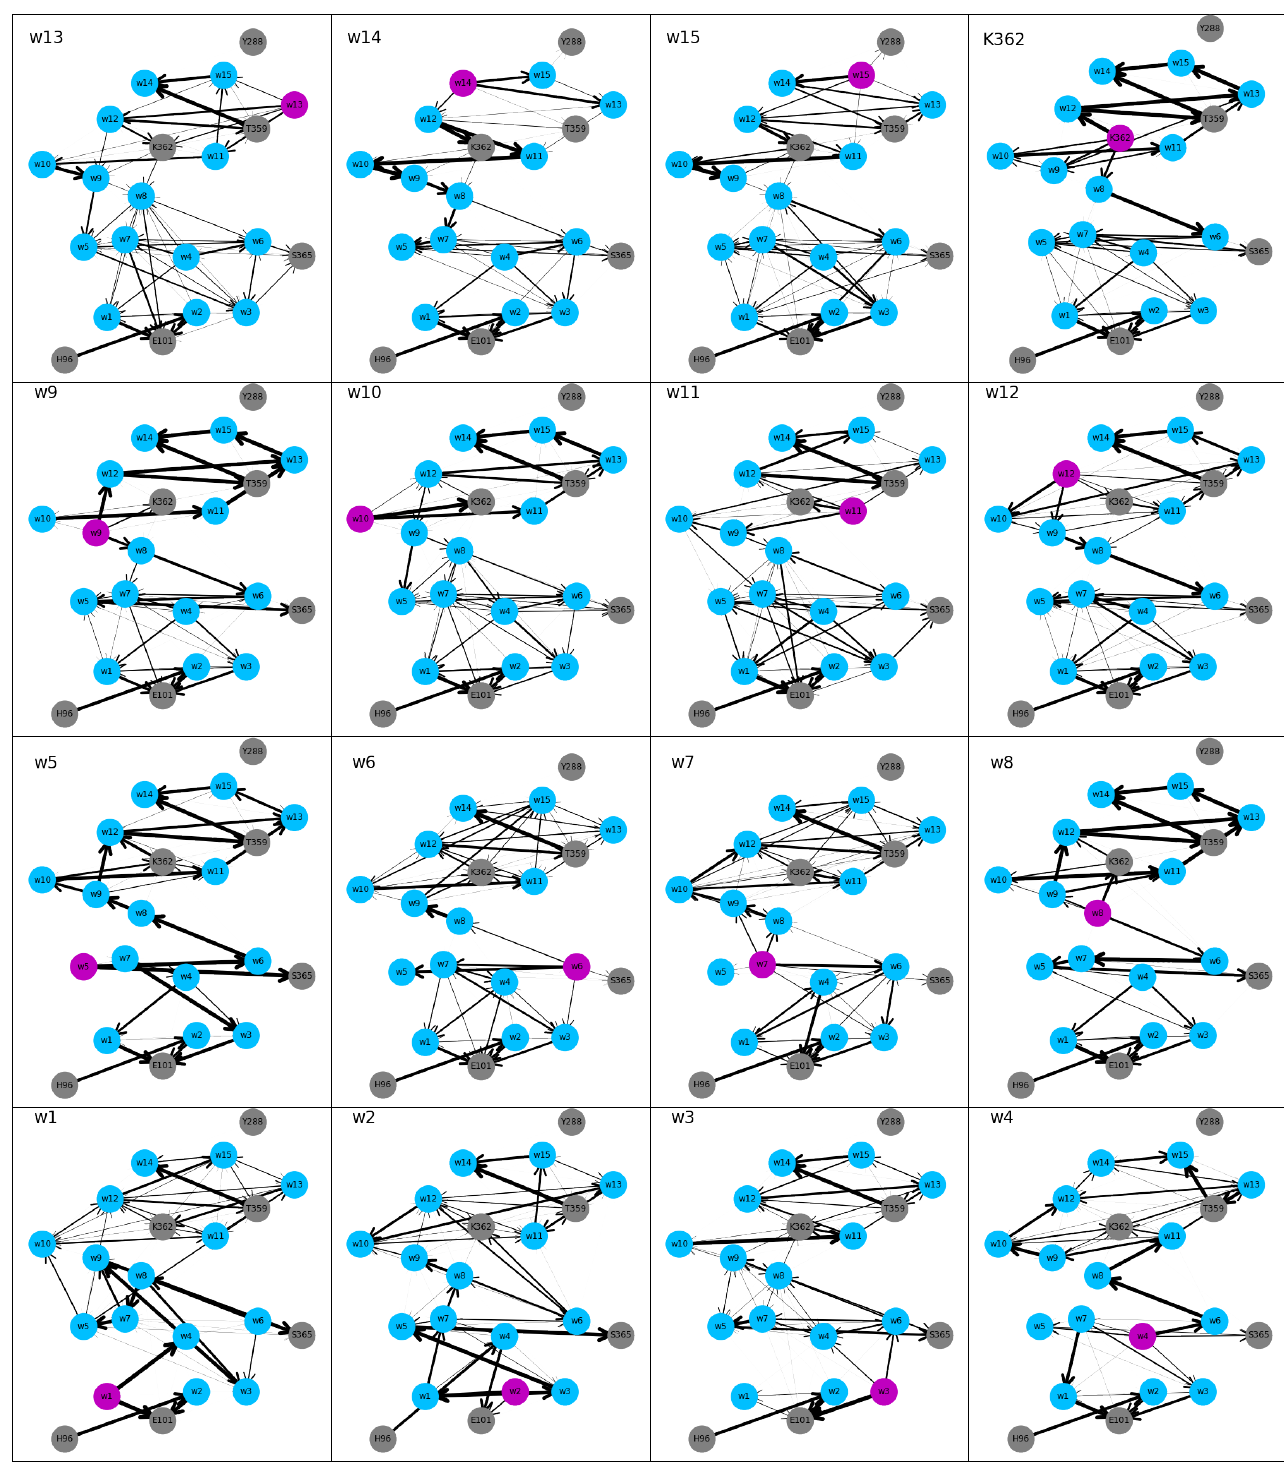
Figure 7. Directed hydrogen-bonded network computed from the MD simulations of “down” models with the excess proton located at different residues. The nodes of the network are the protein residues (in grey) Y288, T359, K362, S365, H96, or E101, and the fifteen water molecules (in blue) in the channel. The residue carrying the excess proton is highlighted in magenta. Edges of the network correspond to hydrogen bonds, shown as arrows pointing from donor to acceptor residue. The thickness of the lines indicate the probability of the hydrogen bonds. Hydrogen-bonded networks of models with protonated H96 and E101, respectively, are shown in Supplementary Figure